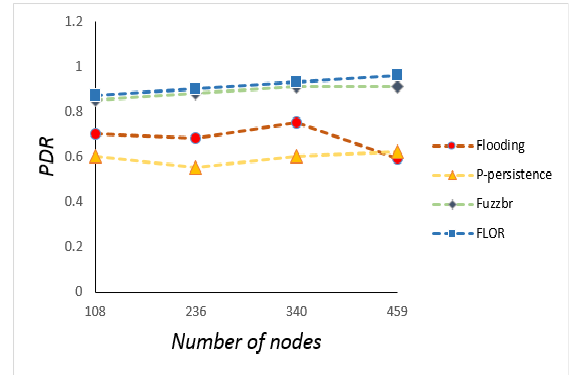
Figure 7. Packet delivery ration for different numbers of vehicles.